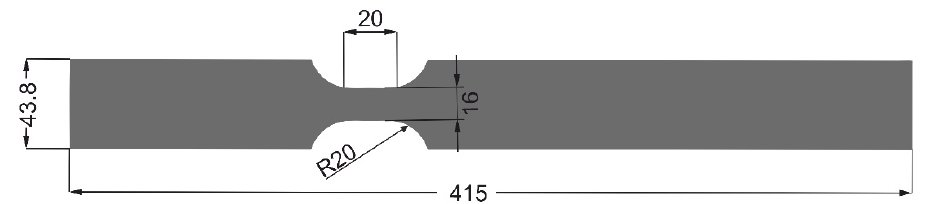
Figure 1. Schematic drawing of a sample in mm.